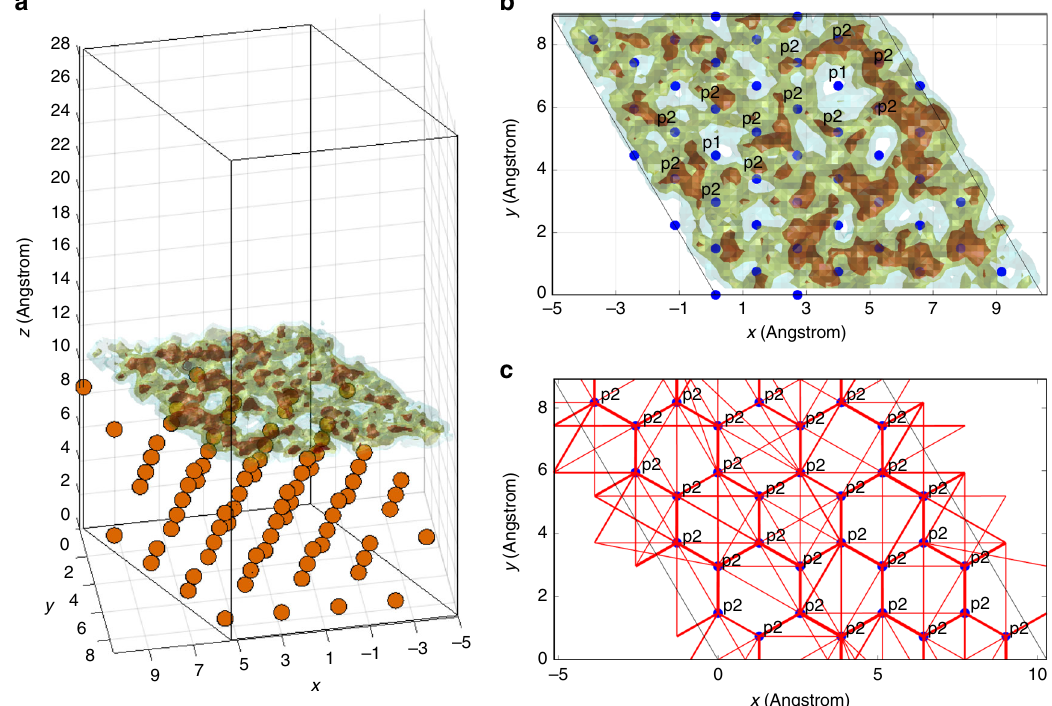
Fig. 8 Li mobility at the Cu surface (determined by molecular dynamics Simulations). a Integrated Li density of 1 diffusing Li atom on the (111) copper surface resulting from a 75 ps MD simulation at 600 K. b Top view of the Li density indicating the Li p2 positions and the energetically less favorable p1 positions. c Detected transitions, represented as red lines, resulted from sampling the surface with the p2 surface positions. The thickness of the lines scales with the number of